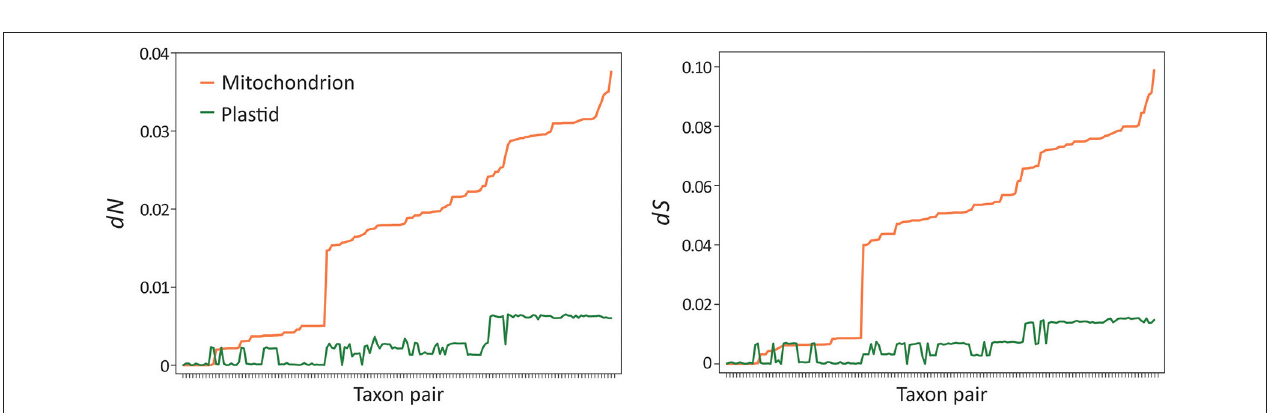
FIGURE 5 | Comparing mitochondrial (left panel) and plastid (right panel) trees reveals different placement of two interspecific hybrid bananas. Genome types (if known) are indicated within parentheses. Taxa underlined are sequenced in this study. BS, bootstrap support.